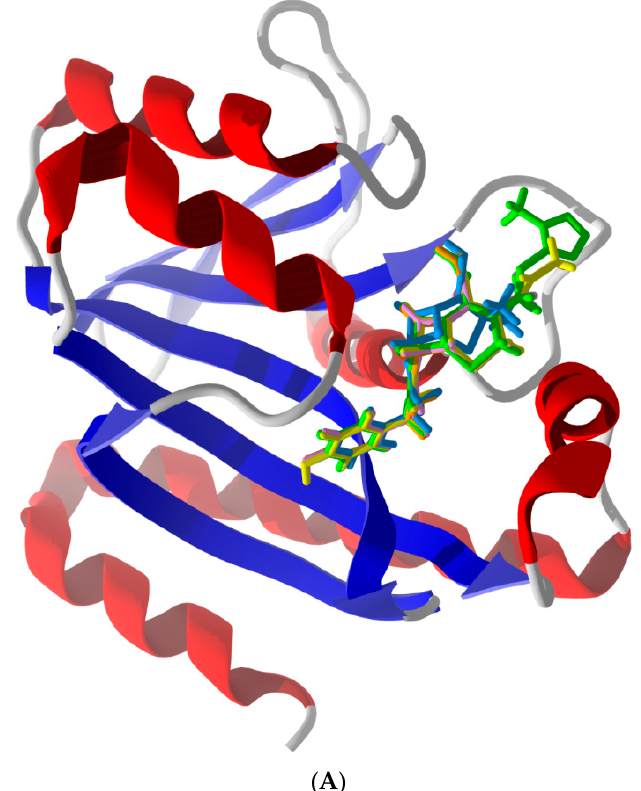
Figure 2. Cont. Figure 2.